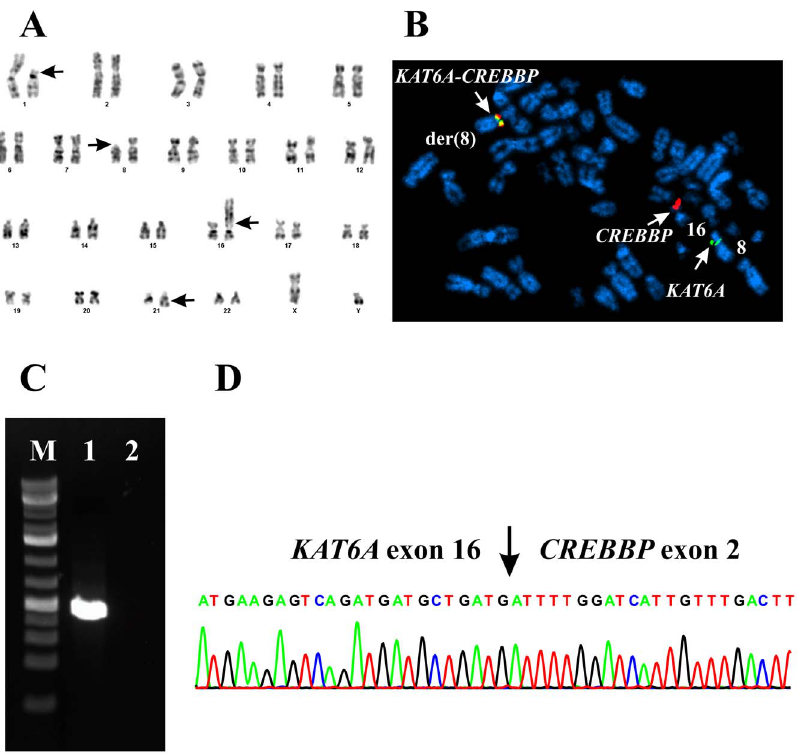
Figure 2. Cytogenetic, FISH and RT-PCR analyses. A) Karyotype at diagnosis showing the chromosome aberrations add(1)(p13), t(8;21)(p11;q22), and der(16)t(1;16)(p13;p13); breakpoint positions are indicated by arrows. B) Co-hybridization FISH analysis with the probes RP11-619A23/RP11-95J11 (red, for CREBBP ) and RP11-642I24/RP11-589C21 (green, for KAT6A ). A fusion signal of the KAT6A and CREBBP BACs is detected on the derivative chromosome 8, indicating the presence of a KAT6A/CREBBP chimera. C) Amplification of a 352 bp cDNA fragment using the primers MOZ-3558F and CBP-431R (lane 1); M, 1 Kb DNA ladder (GeneRuler, Fermentas); Lane 2, Blank, no RNA in cDNA synthesis. D) Partial sequence chromatogram of the 352 bp cDNA fragment showing that exon 16 of KAT6A is fused to exon 2 of CREBBP